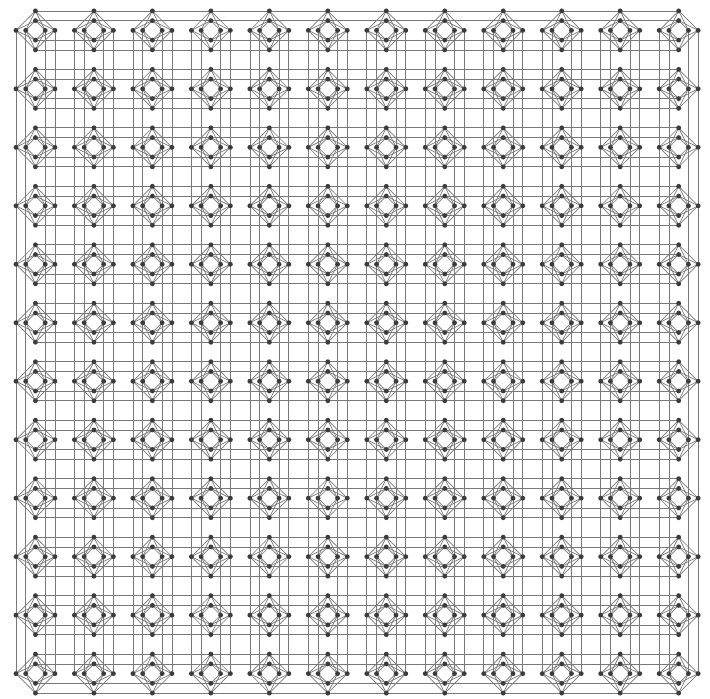
Figure 1. The Chimera interconnection graph for the D-Wave 2X system is a 12 × 12 array of unit cells , where each cell is a 4 × 4 bipartite